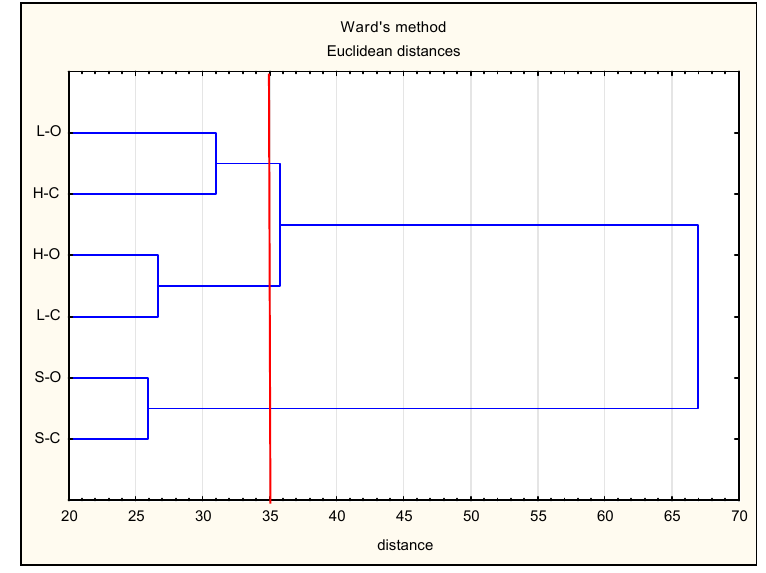
Figure 6. Dendrogram resulting from Ward’s method of hierarchical cluster analysis of antioxidant